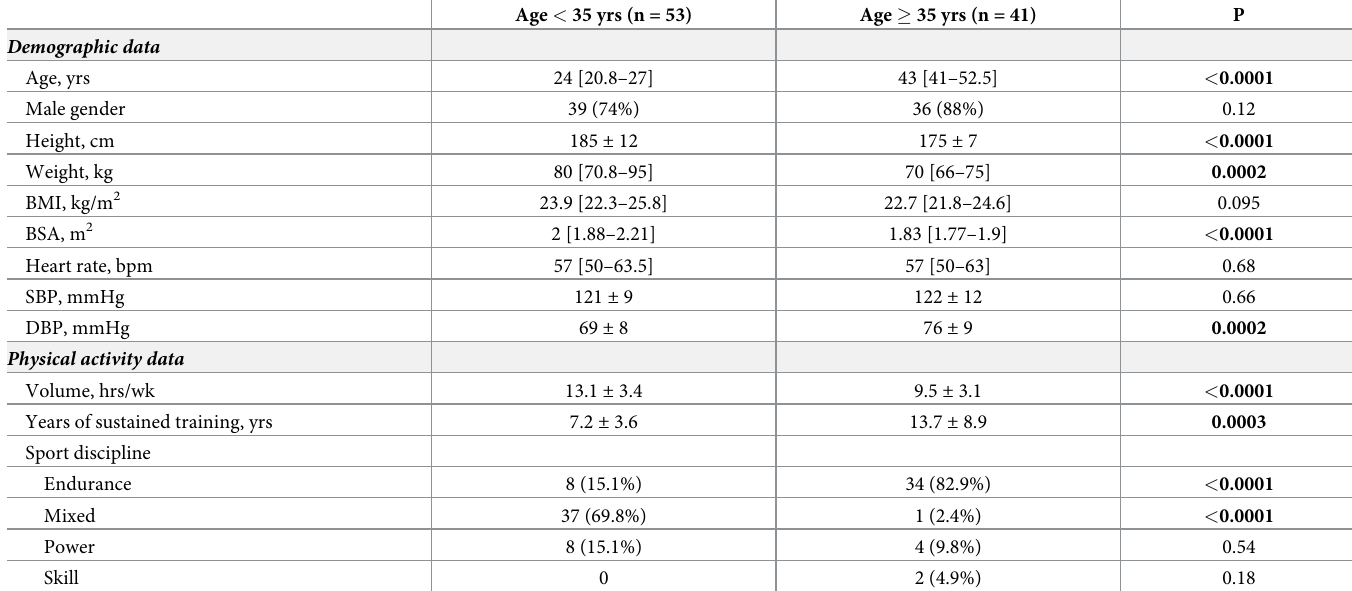
Table 1. Population